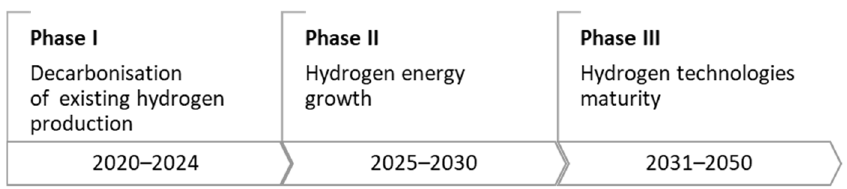
Figure 1. Hydrogen road map for EU. Source: own elaboration based on [11].